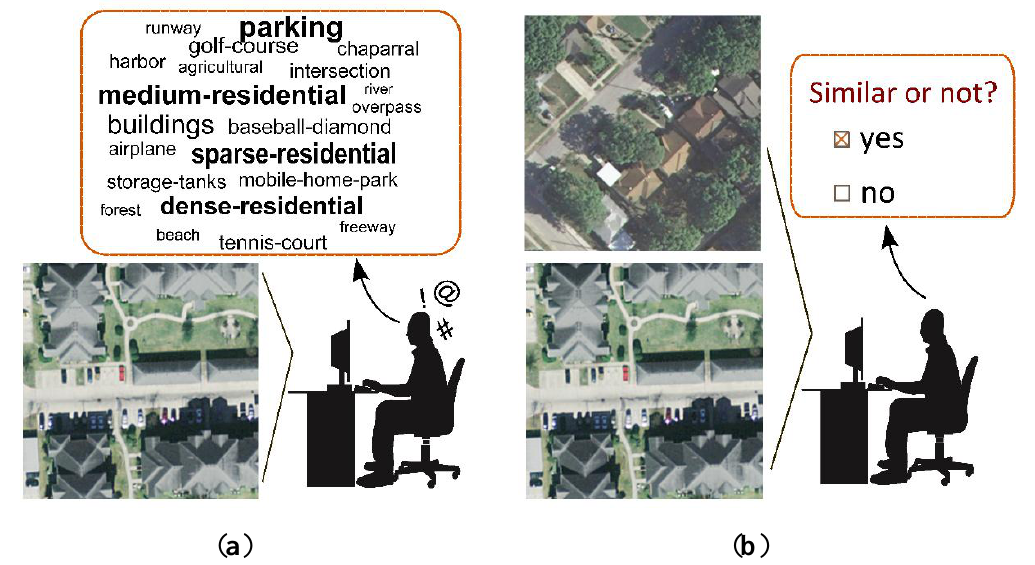
Figure 1. Comparison of the expert knowledge required for the use of class labels ( a ) and pairwise constraints ( b ) as prior information for annotating remote sensing